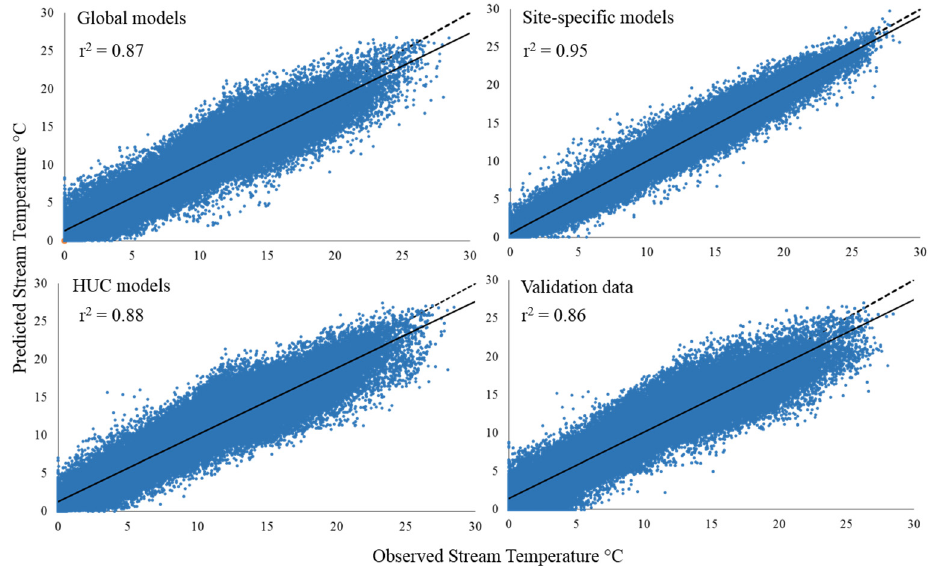
Figure 7. Stream temperature predicted from the global, site-specific, and HUC models for 2000–2009 vs. the observed values. The validation data plot is the jackknife-by-site, leave-one-out validation data for all years vs. the predicted temperatures for those sites from the global models for each year. The solid black line is the simple linear regression between the predicted and observed temperatures (with r 2 for that relationship). The dashed line is the one-to-one relationship.